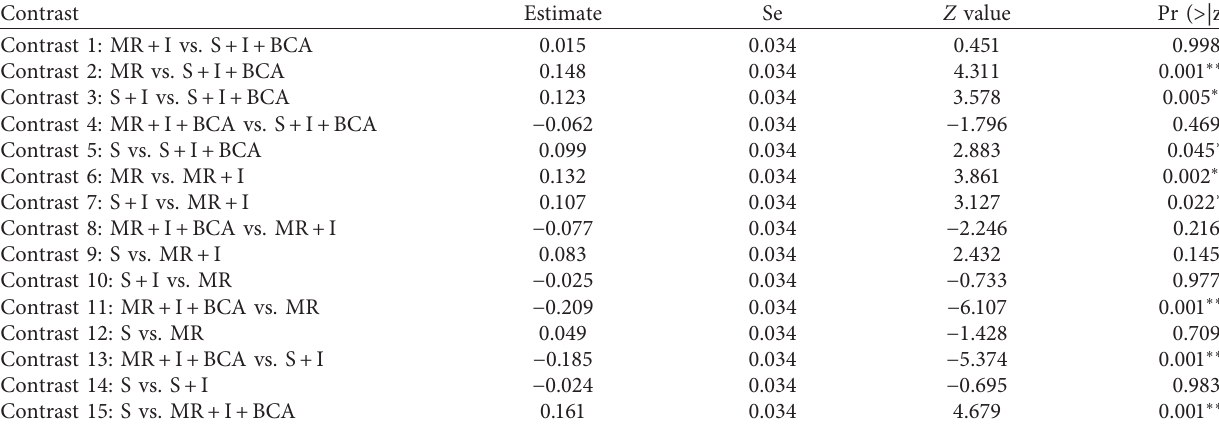
Table 1: Multiple comparisons of treatment combinations leaf damage means, as infested by Tuta absoluta using the Tukey contrast matrix. Contrast